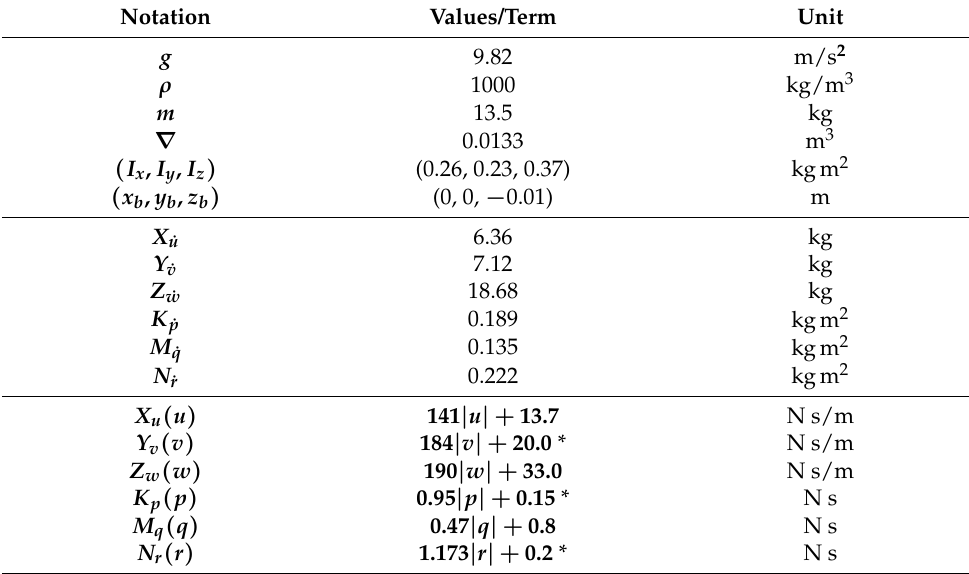
Table 4. Parameters used for the model, adapted from [15] with changed drag